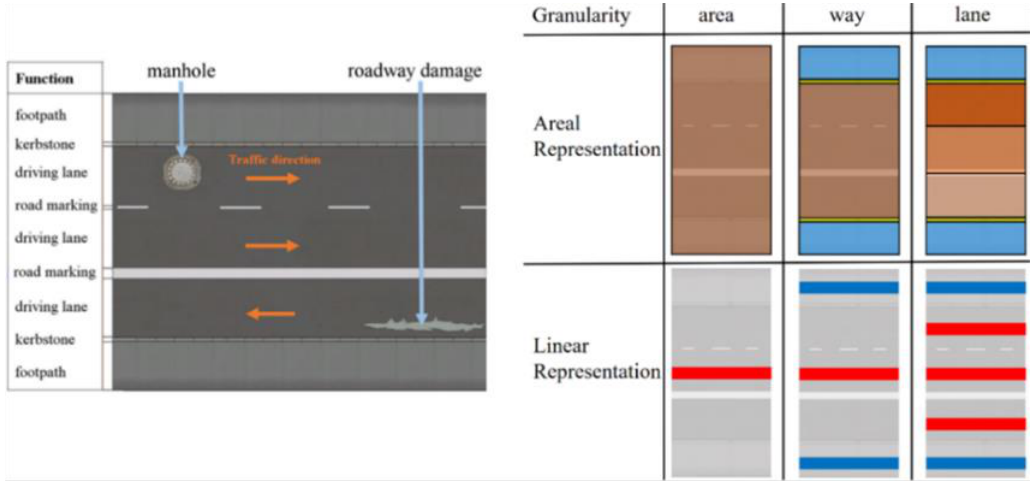
ff erent levels of granularity (areal and linear Figure 4. Street Section in different levels of granularity (areal and linear representation). Figure 4. Street Section in di